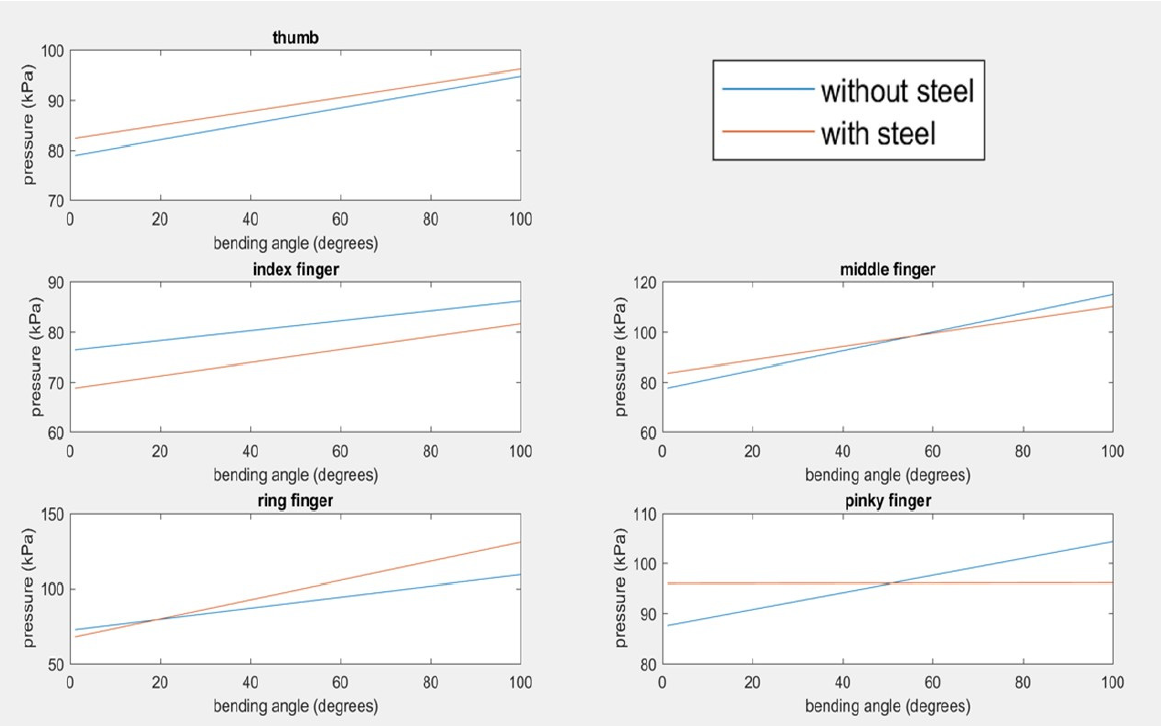
Figure 10. Best fit line of angle vs. pressure for 10 subjects using averaged point-slope intercept m and b values for five the fingers.